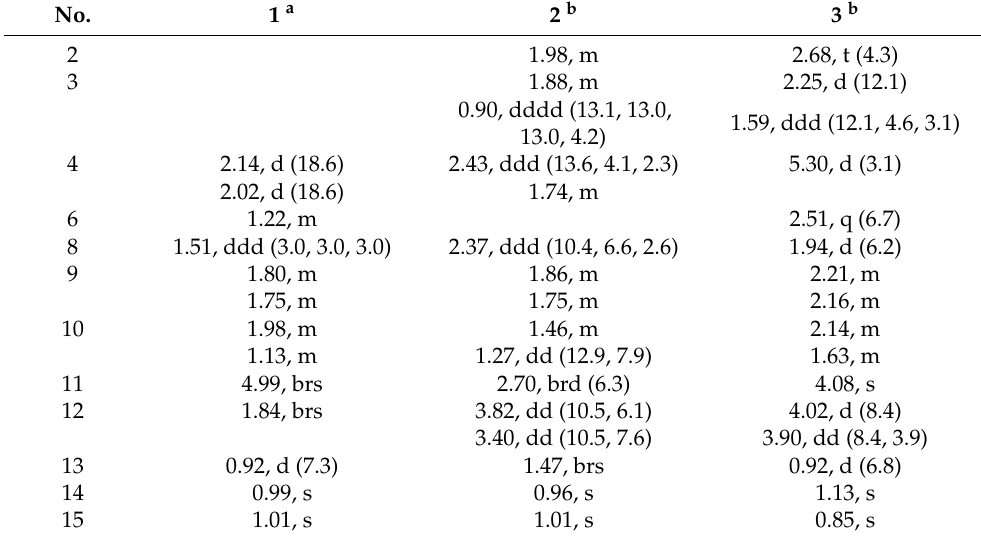
Table 1. 1 H NMR spectroscopic data of compounds 1 – 3 (500 MHz, δ in ppm).